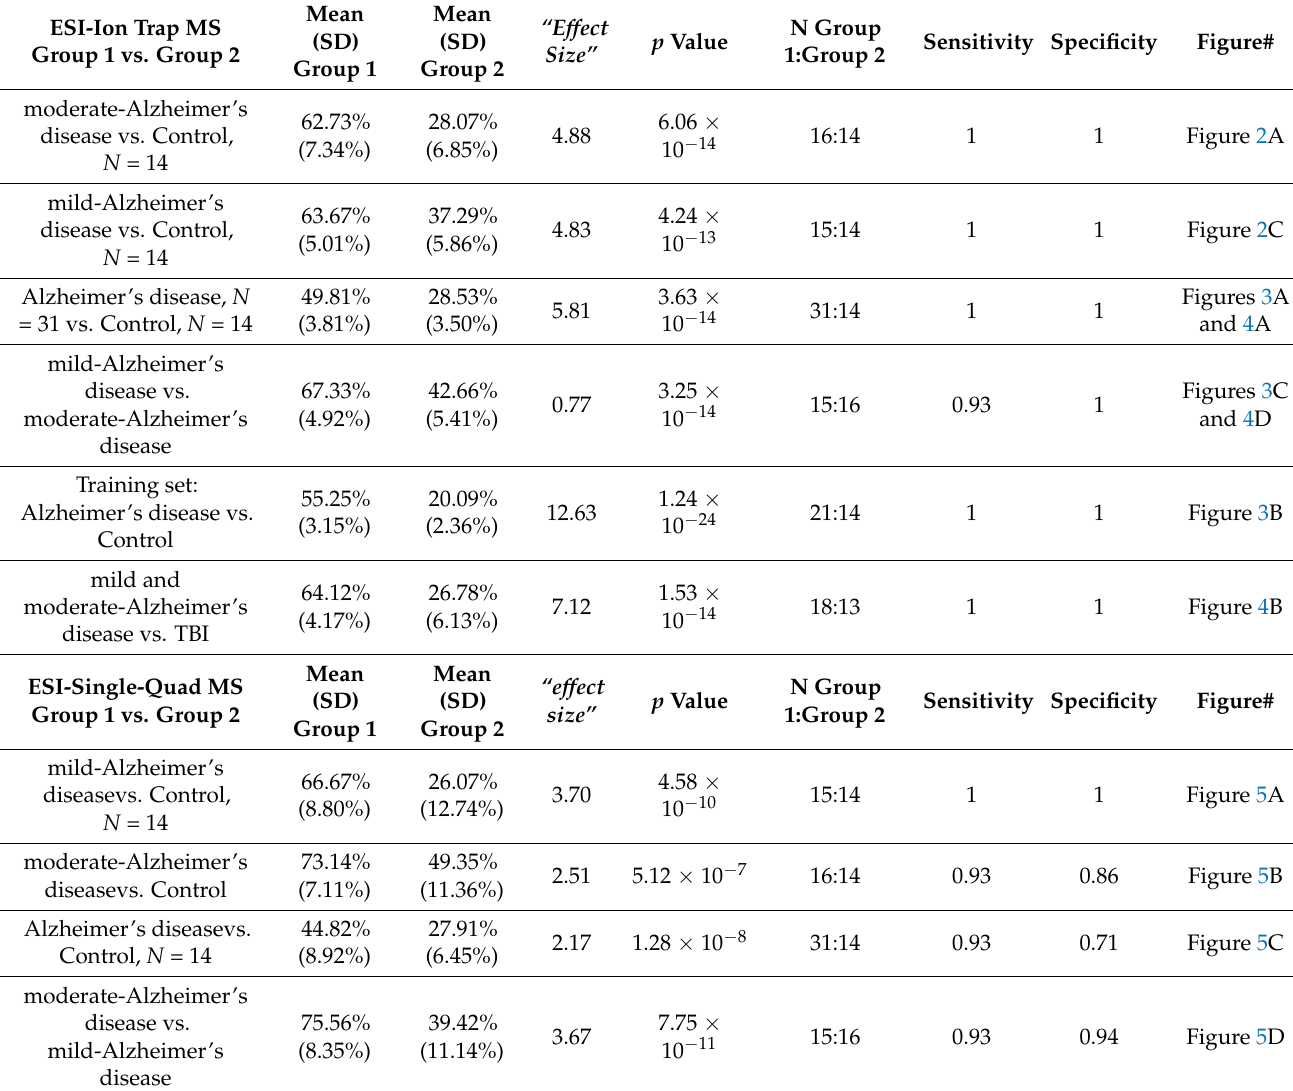
Table 2. LOOCV Test Metrics for “true-pathology” group